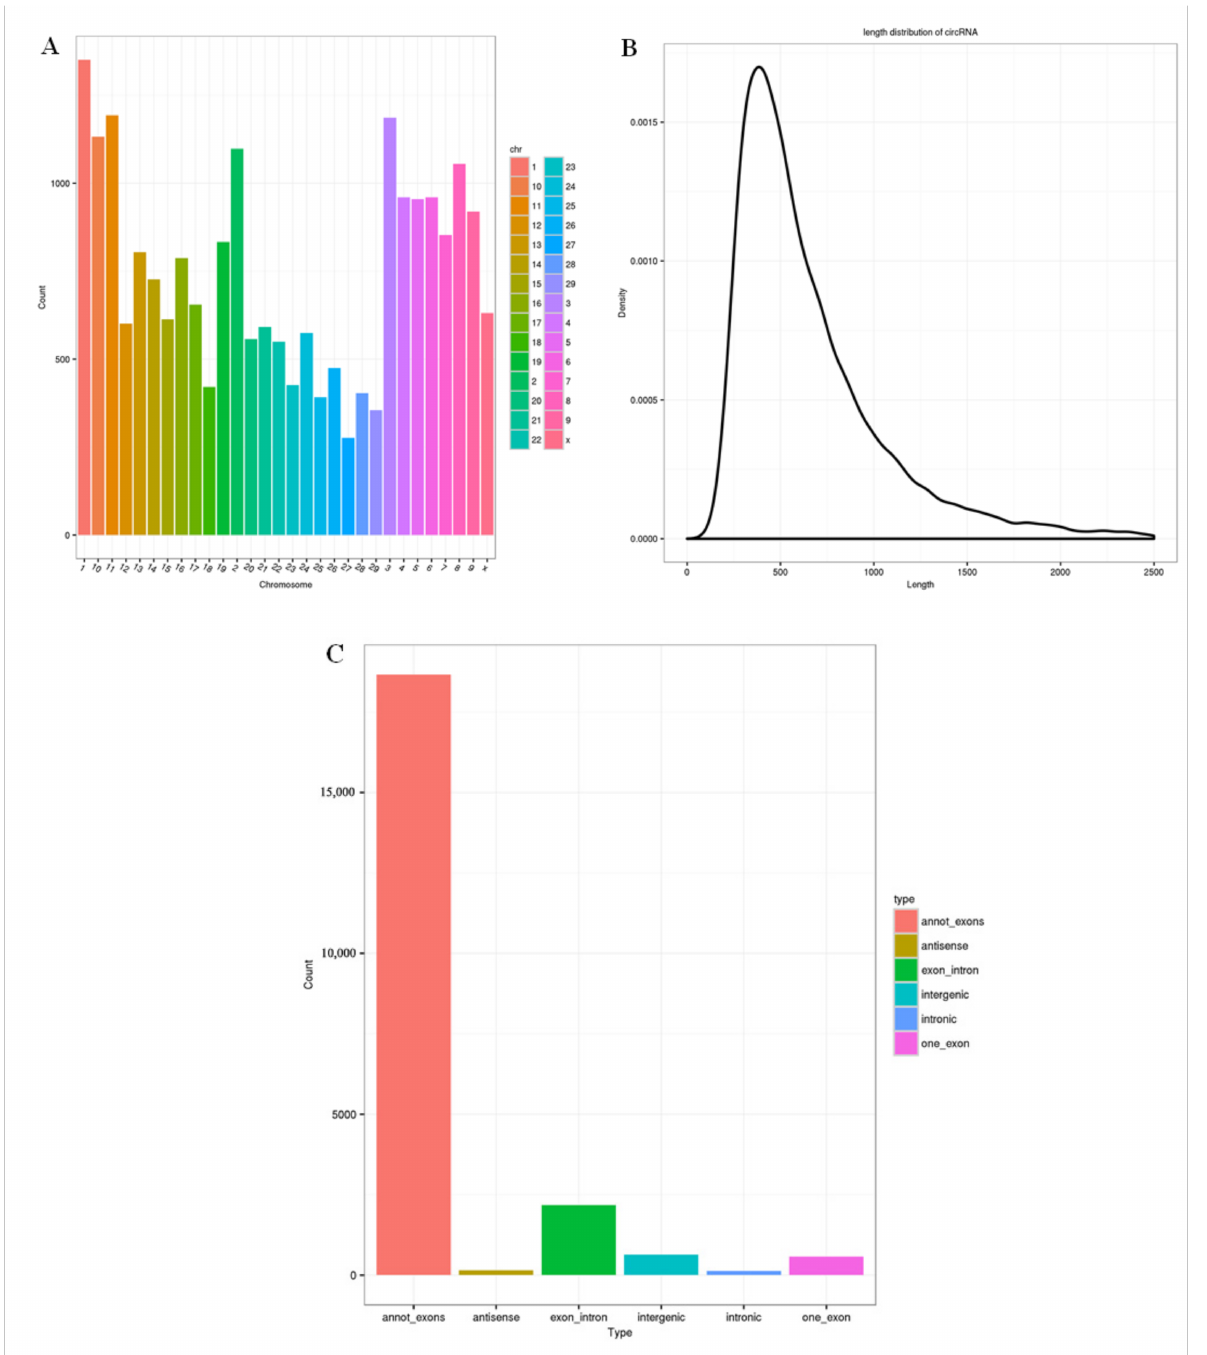
Figure 1. The location, length, and type of identified circRNAs. ( A ) The chromosome distribution of identified circRNAs, ( B ) the length distribution of identified circRNAs, and ( C ) the number of the six types of